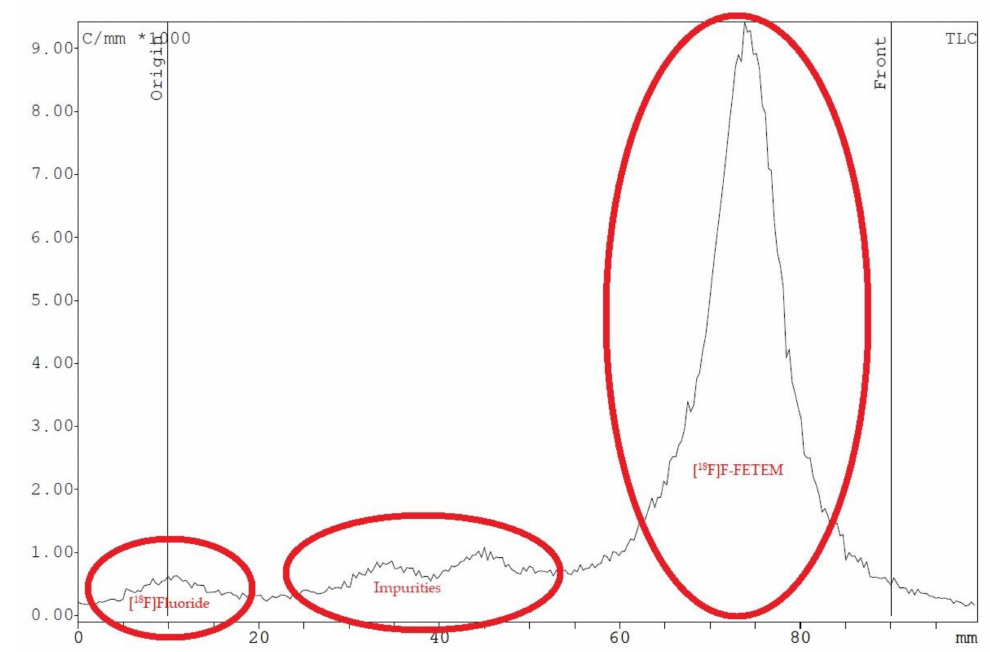
Figure 3. Radio-TLC analysis of radiochemical impurities of [ 18 F]F-FETEM.